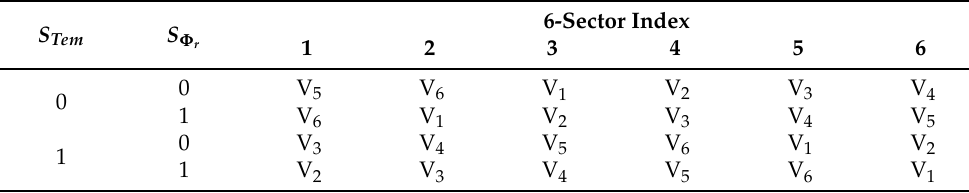
Table 1. Conventional switching table in DTC